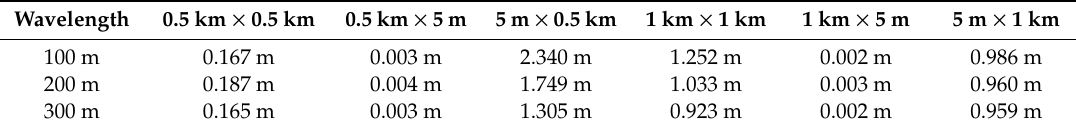
Table 16. The RMS of smoothing velocity bunching phase results with di ff erent wavelength (the direction of the smoothing window is in two directions at the same time, in the azimuth and in the range).